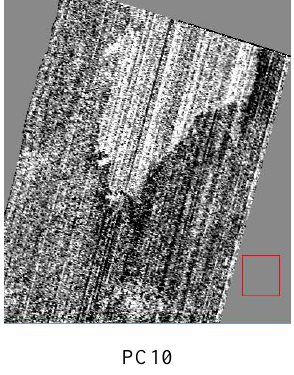
Figure1. Principal Component (PC) image display (a) PC1